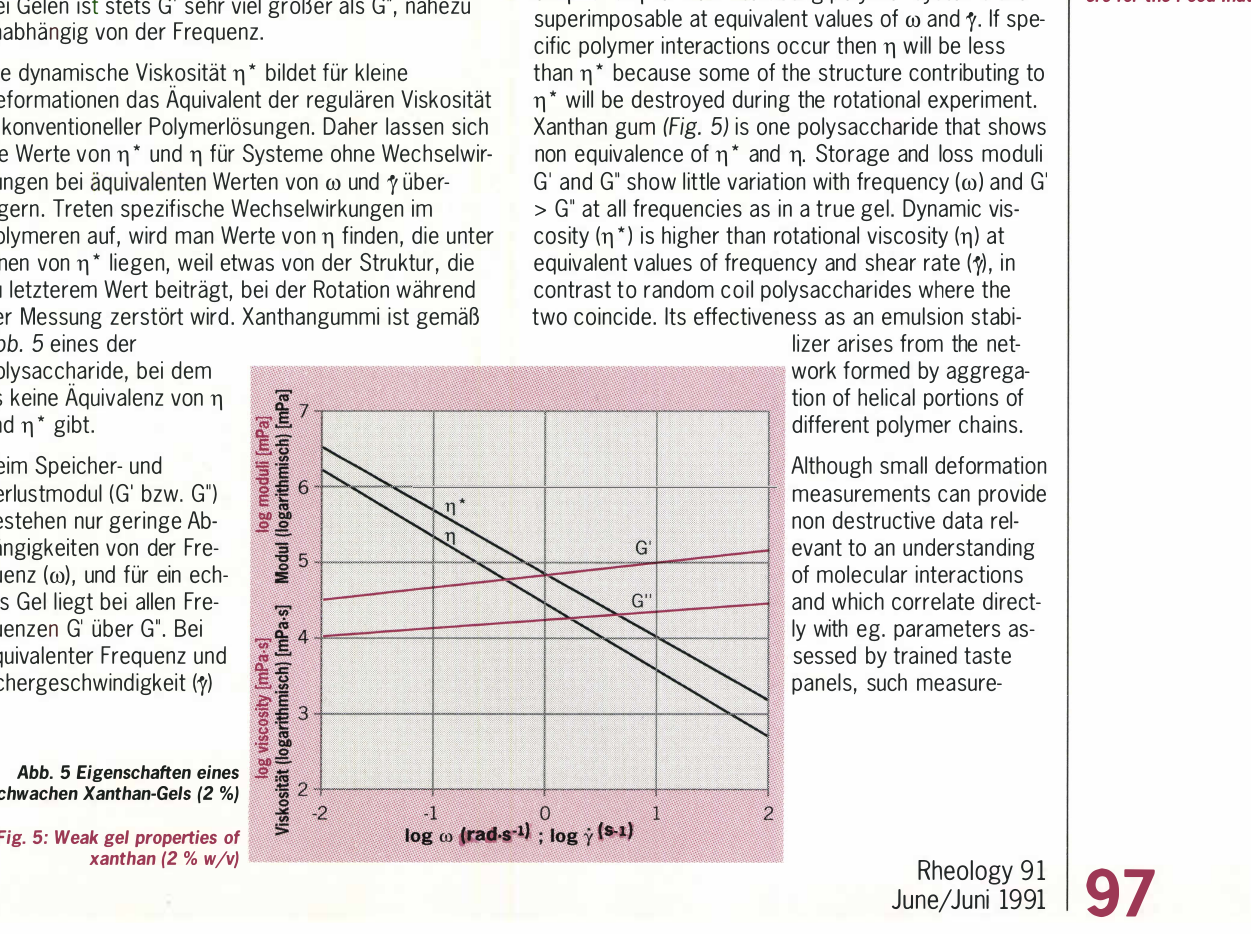
Fig. 4: Characteristics fea­ tures of polysaccharide me­ chanical spectra for a strong gel (2 % agar), and concen­ trated (5 % -carrageenan) and dilute (5 % dextran) so­ lutions. From Morris, E.R. 1984. Reprinted with permis­ sion from 'Gums and Stabilis­ ers for the Food Industry'